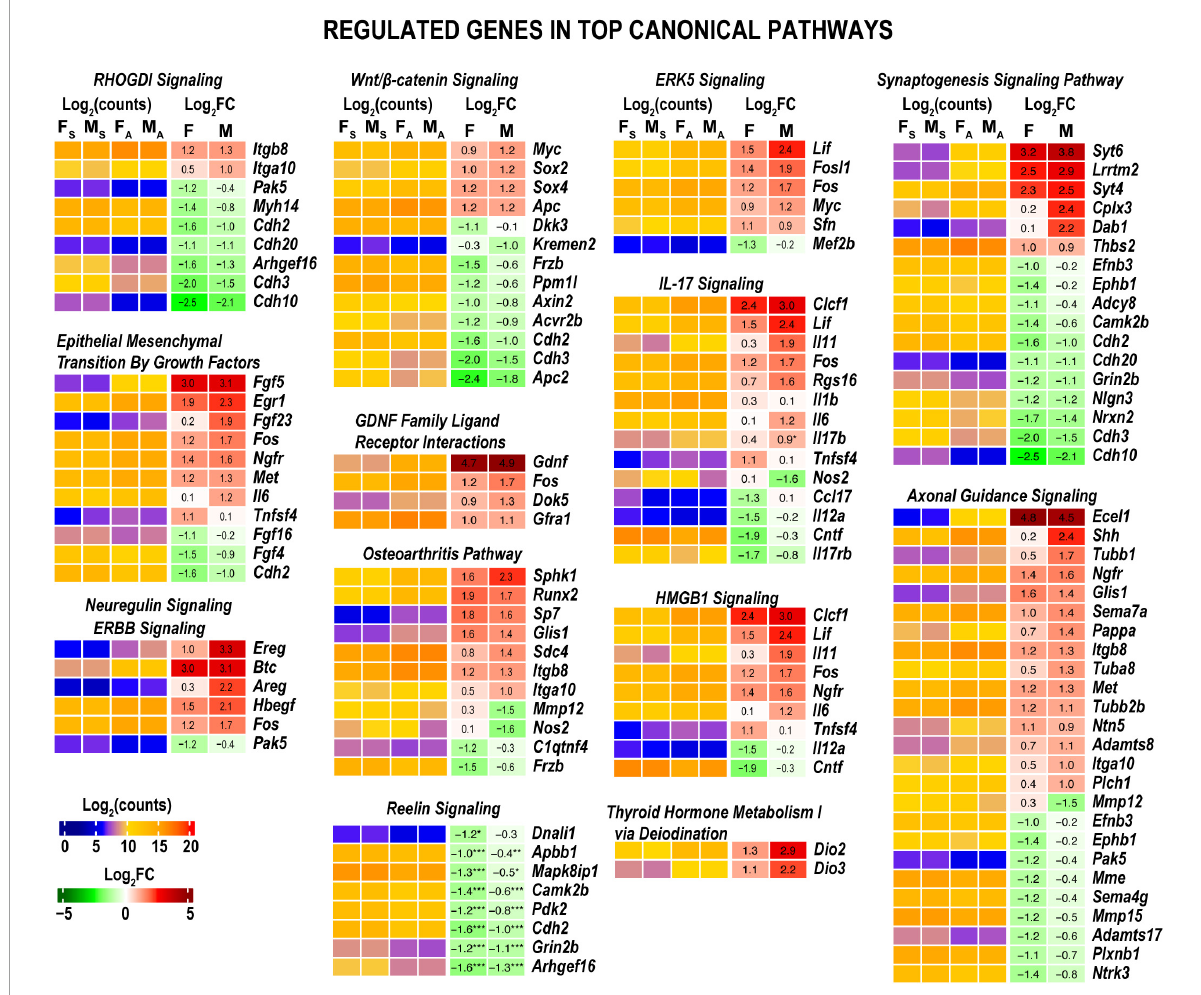
FIGURE4 Axotomy affected major nerve injury-related canonical pathways. Histograms show DEG specific to canonical pathways highlighted in Figure 3 . Heatmaps display normalized log 2 (counts) in sample groups (F S , female sham; M S , male sham; F A , female axotomy; M A , male axotomy) and log 2 FC in female (F) and male (M); [ n = 6 mice/group, 2 mice/sample (pooled), 3 sample/group] of respective DEGs. Log 2 FC significance was determined in DESeq2 using the Wald test. DEGs were sorted by log 2